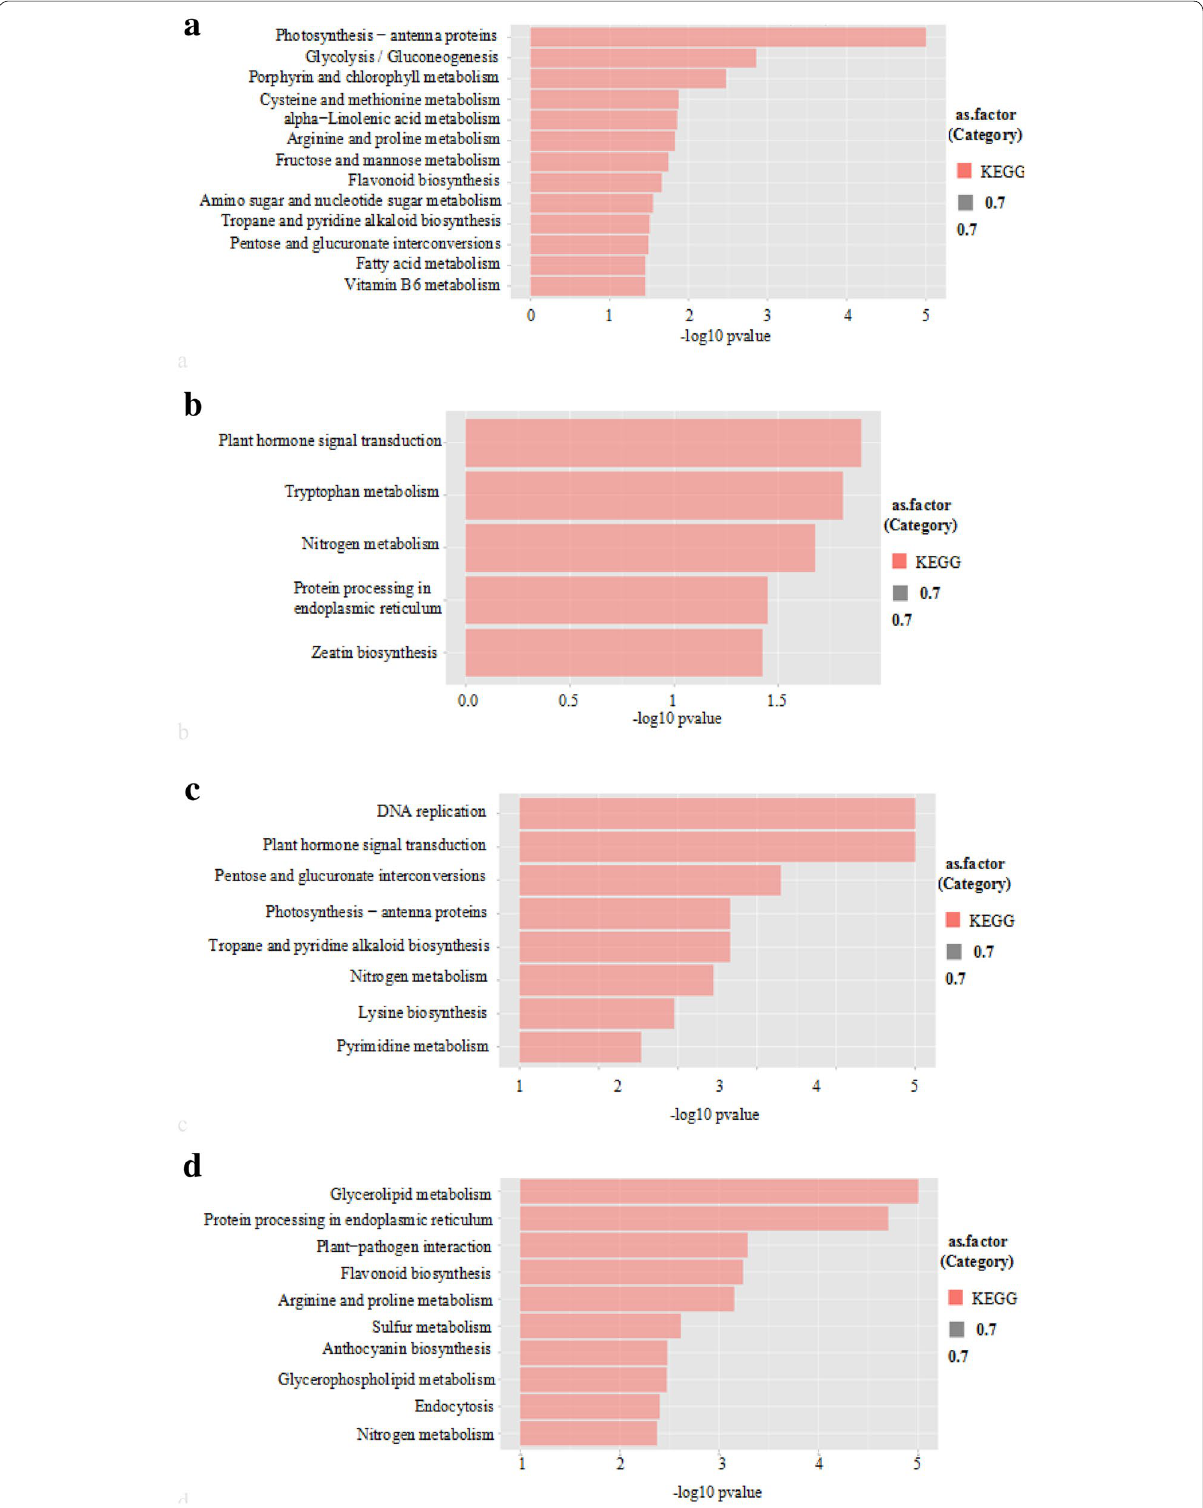
Fig. 5 Pathway enrichment affected by AtOFP8 gene. a Pathway enrichment of 35S:HA ‑ AtOFP8 vs Col‑0 up‑regulated genes. b Pathway enrichment of 35S:HA ‑ AtOFP8 vs Col‑0 down‑regulated genes. c Pathway enrichment of Atofp8 ‑ 1 vs Col‑0 up‑regulated genes. d Pathway enrichment of Atofp8 ‑ 1 vs Col‑0 down‑regulated